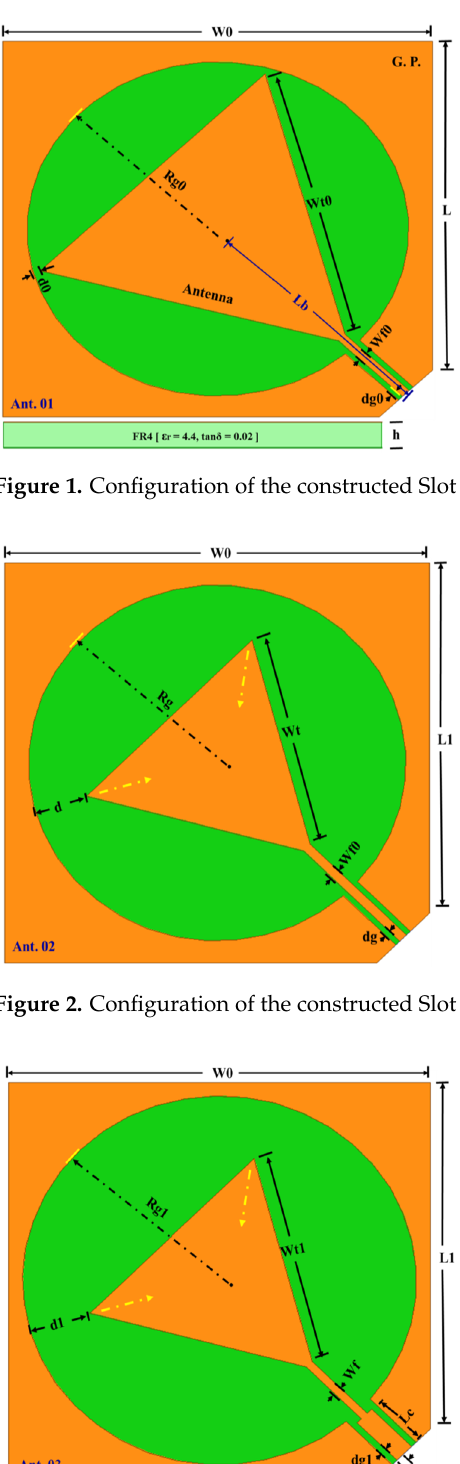
Figure 3. Configuration of the constructed Slot antenna 3.